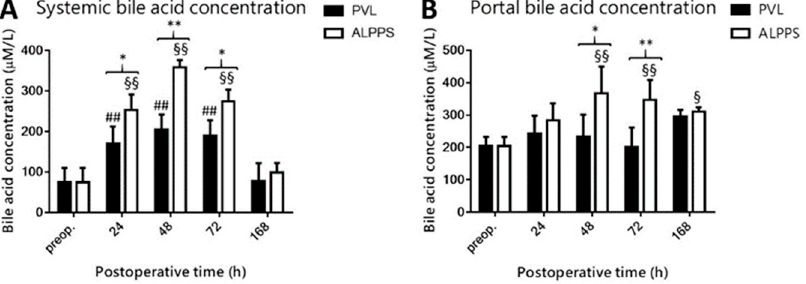
Figure 5. Effect of portal vein ligation (PVL) and associating liver partition and portal vein ligation for staged hepatectomy (ALPPS) on systemic bile acid (BA) concentration ( A ) and portal BA concentration ( B ). BA levels were determined preoperatively (preop.) and at 24 h, 48 h, 72 h, and 168 h after PVL and ALPPS ( n = 6 per time point per group). * p < 0.05, ** p < 0.001 versus PVL; ## p < 0.001 PVL versus corresponding controls (preop.); § p < 0.05, §§ p < 0.001 ALPPS versus corresponding controls (preop.). Statistical analysis was performed with a two-way ANOVA and Tukey’s post hoc test. Data are presented as mean ± 1 standard deviation (SD).